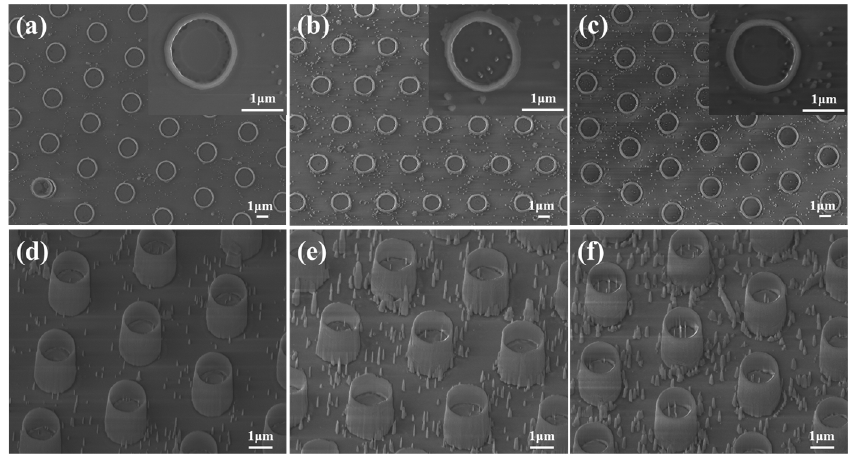
Figure 7. Plane and tilted view SEM images of the β -Ga 2 O 3 microtubes (MTs) samples oxidized at 950 °C for ( a , d ) 20 min, ( b , e ) 30 min, and ( c , f ) 40 min. Insets at the top right corner show high- magnification images of the same sample.